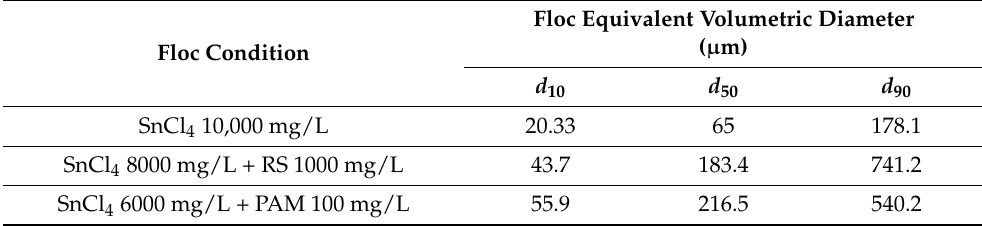
Table 2. Particles size distribution of 10,000 mg/L SnCl 4 , 8000 mg/L SnCl 4 with 1000 mg/L RS as coagulant